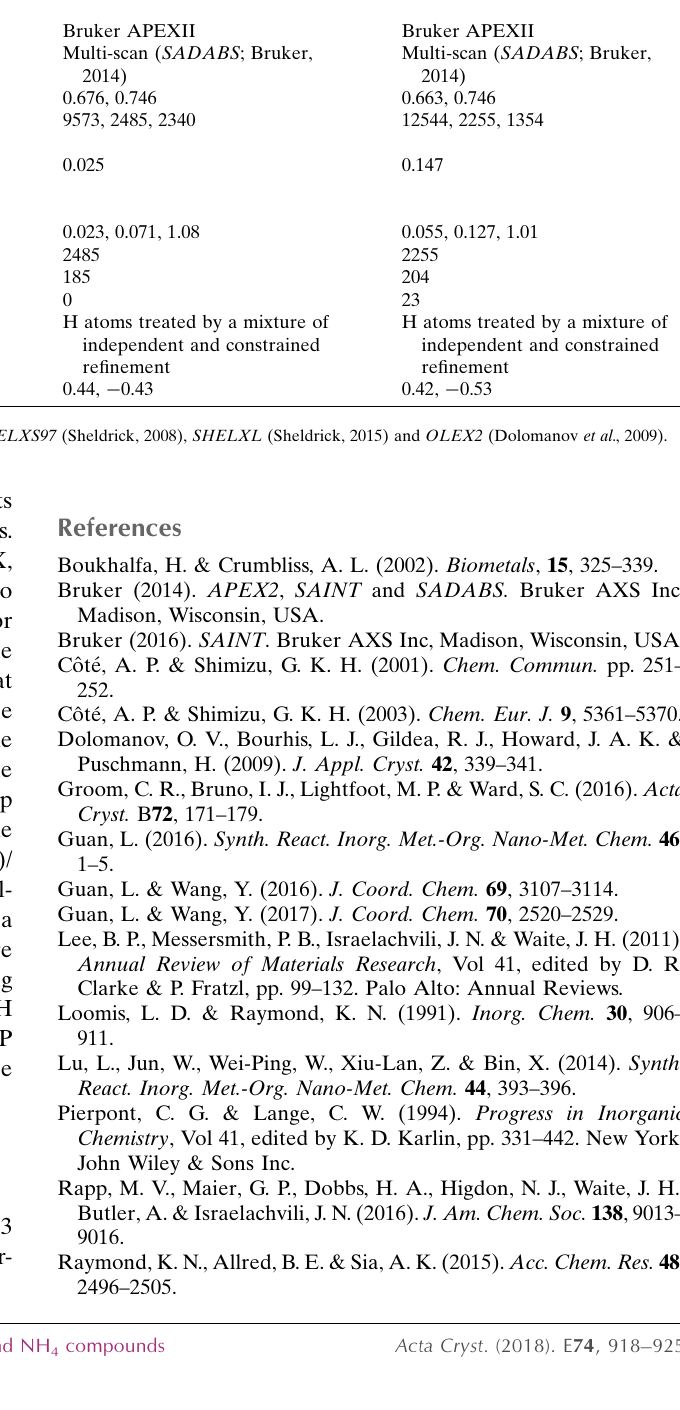
Crystal data Chemical